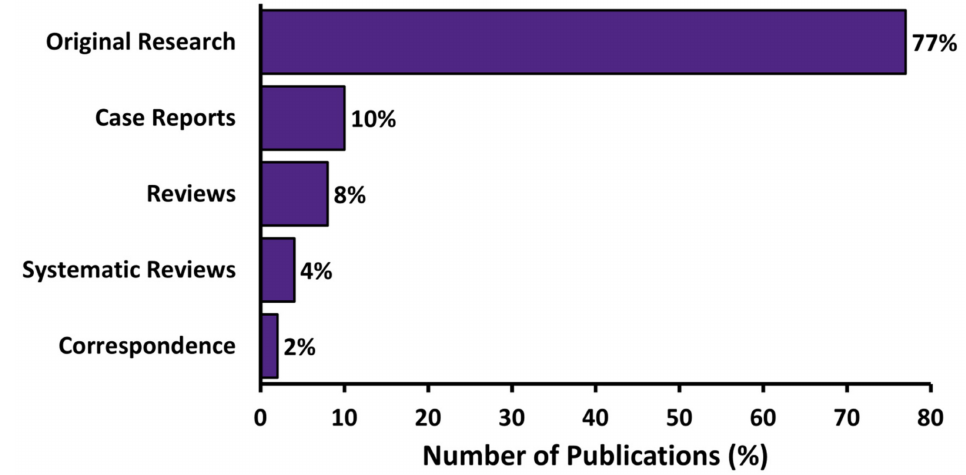
Figure 2. Percentage of publications by research category.